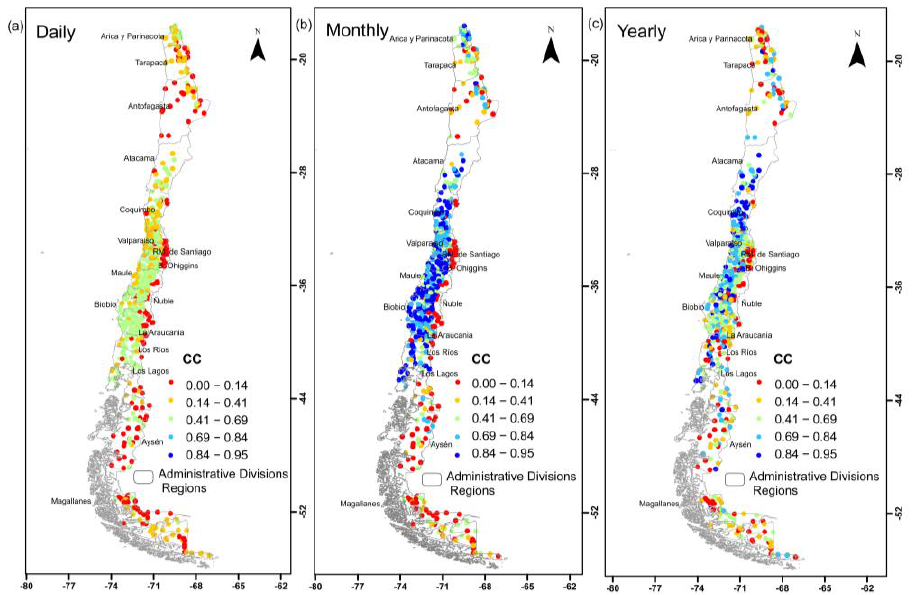
Figure 10. Spatial distributions of CC for the Daily, Monthly, and Yearly resolutions for IMERG Early product.